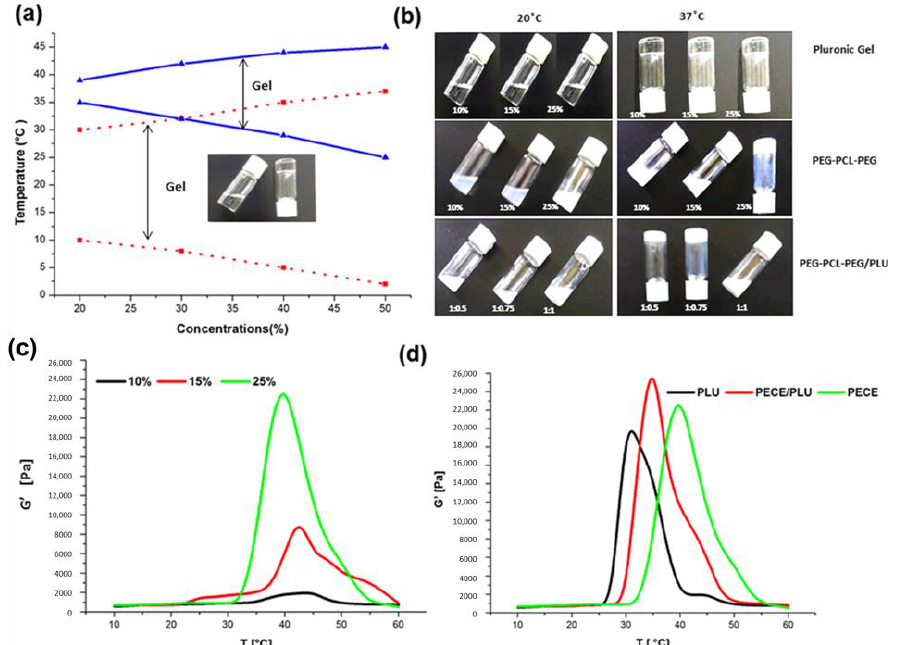
Figure 4. ( a ) Graphical depiction of sol-gel conversion of Pluronic F127 (red) and PEG-PCL-PEG hydrogel (blue). ( b ) Photograph of tube inversion method for sol-gel conversion of the hydrogels at different concentrations. Rheological analysis of ( c ) PEG-PCL-PEG hydrogels at different concentra- tions and (d) comparative analysis of Pluronic, PEG-PCL-PEG and PEG-PCL-PEG/PLU hydrogels at a concentration of 25% w / v .